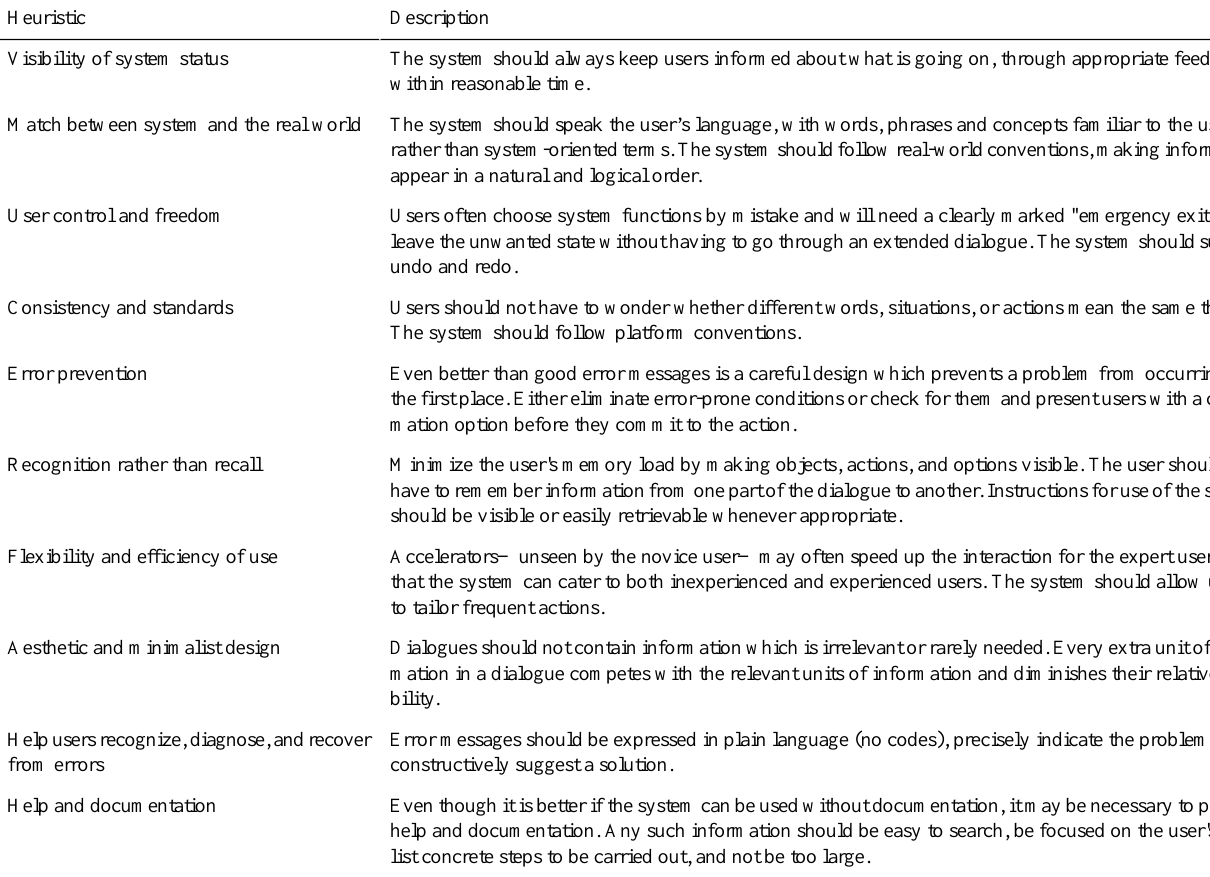
Table 2. Nielson usability heuristics